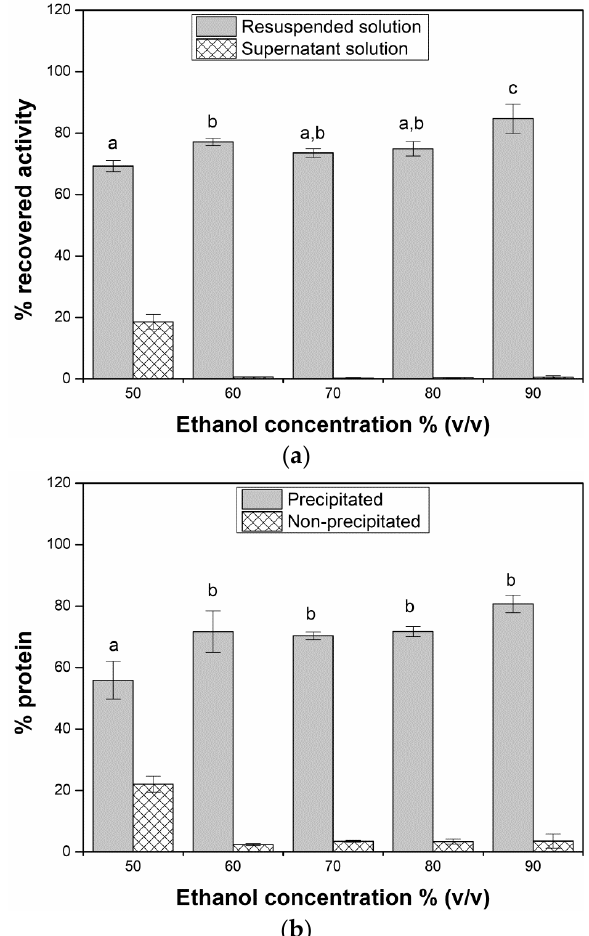
Figure 4. Influence of the ethanol concentration (vol %) on the ( a ) percentage of recovered activity, and ( b ) percentage of precipitated protein of amyloglucosidase (AMG 300L). Assay conditions: 30 min precipitation under static conditions in an ice bath. AMG solution prepared in 50 mM sodium citrate buffer pH 4.5. Note: Values are shown as the mean of triplicate experiments ± s.d. Means followed by the same letter are not statistically different by Tukey’s test ( p < 0.05). Percentage of protein was calculated taken the initial protein as 100%.